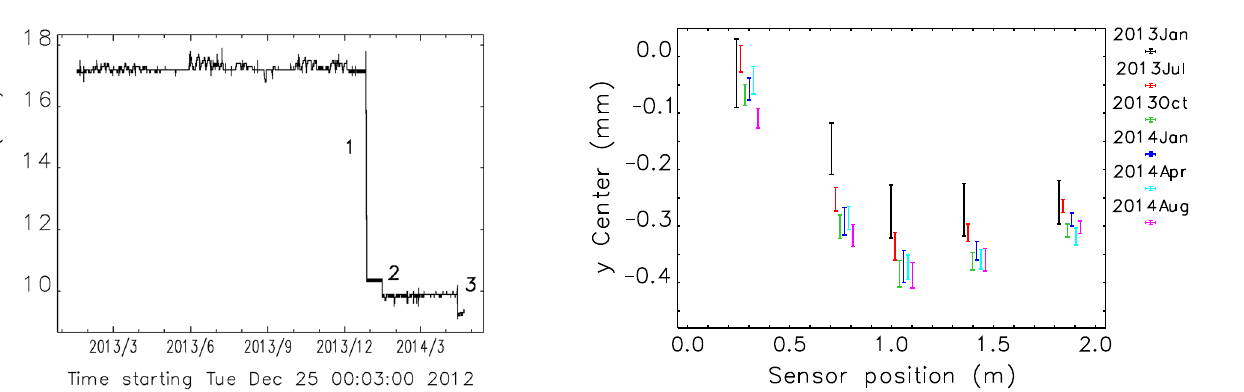
FIG. 16. Measured vertical position of the vacuum chamber over 15-month period using beam-based